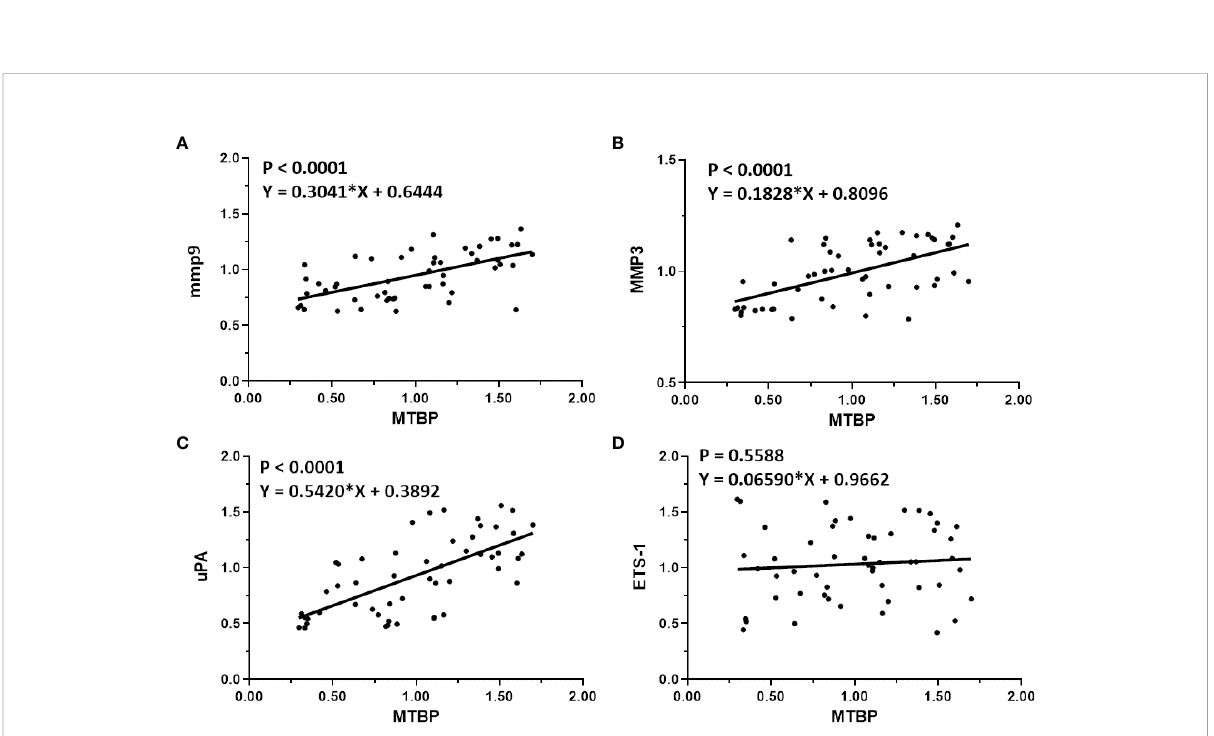
FIGURE 4 Co-relations between MTBP with ETS-1 ’ s downstream genes in HCC clinical specimens. The scatter plot was drawn with the expression level of MTBP as the abscissa and the expression levels of mmp9 (A) , mmp3 (B) , uPA (C) , and ETS-1 (D) as the ordinate. The results also show the P- value and regression equation of the linear regression fi tting